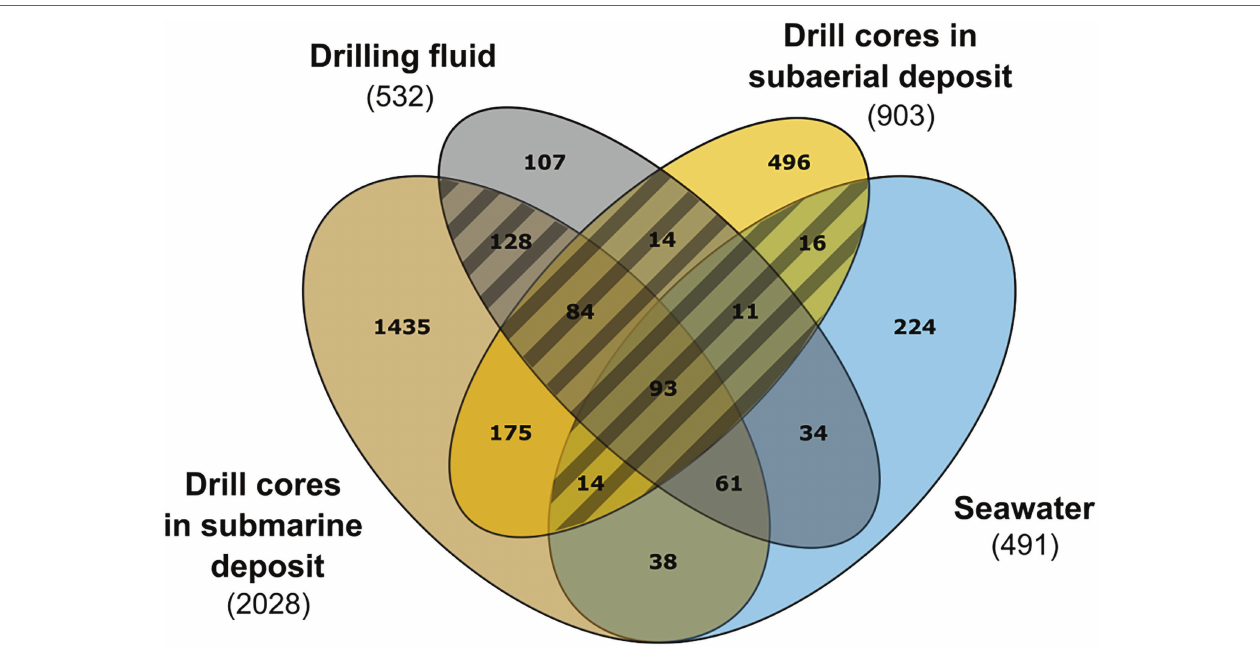
FIGURE 2 | Contamination assessment by an overlap approach between drill cores from the subaerial and submarine deposits, drilling fluid, and seawater samples. Five drilling fluid samples (in grey): 1B49ZC, 1C17ZC, 1C39ZC, 1C51ZC, 1C59ZC, 4 sea samples (in blue): SW_10, SW_20, SW_30, SW_50, 4 samples from the subaerial deposit (in yellow): C4, C9, C13 and C17, and 13 samples from the submarine deposit (in light brown): C22, C27, C33, C36, C39, C42, C45, C49, C52, C55, C59, C62, C65. Hatched area: 360 ASVs considered as